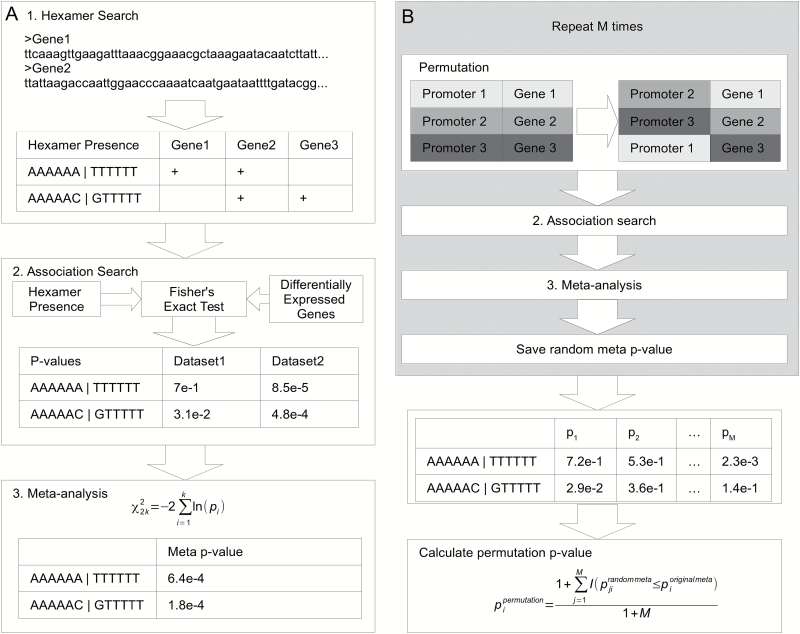
The pipeline for genome-wide association analysis for putative cis-elements associated with auxin response. (A) Three steps of the pipeline: (1) exhaustive hexamer search in the upstream regions; (2) analysis of association between the hexamer’s presence in the upstream region and auxin up- (down-) regulation of the gene; and (3) meta-analysis across all data sets. (B) Permutation test scheme, part of step (3).